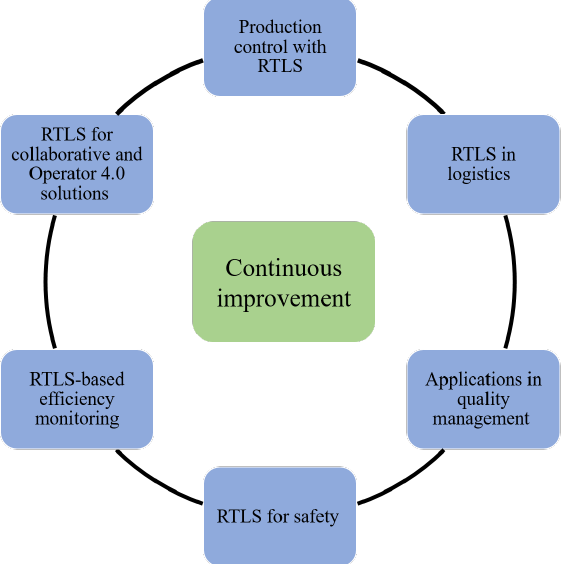
Figure 1. Use of real-time locating system (RTLS)-based positioning information by the different parts of the manufacturing environment. Continuous improvement is a central element of an RTLS